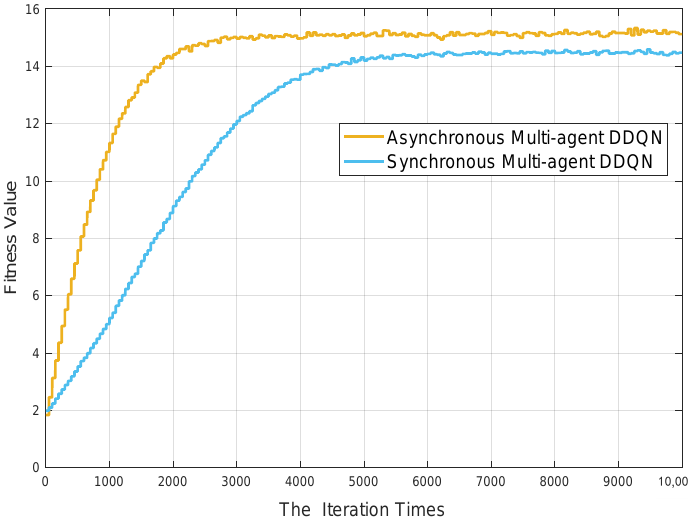
Figure 7. The convergency process of multi-agent DDQN